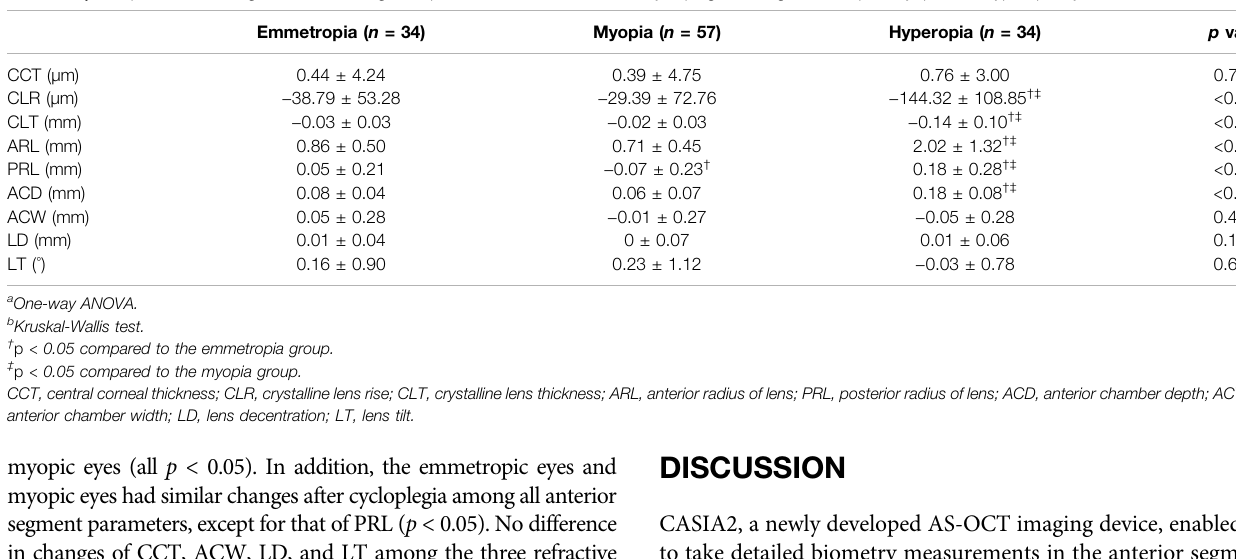
Before cycloplegia